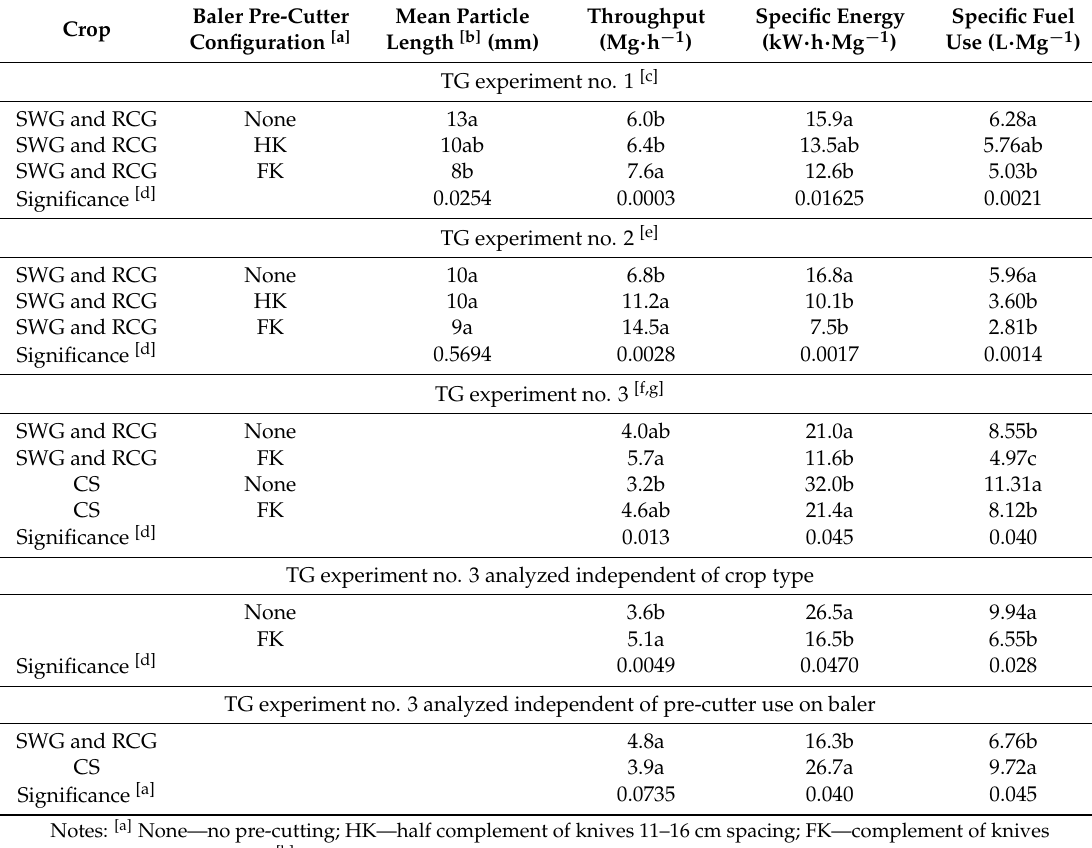
Table 9. Mean particle length and specific energy requirements (both on a dry basis) for tub grinding large round bales (TG Exprs. Nos. 1–3, Table